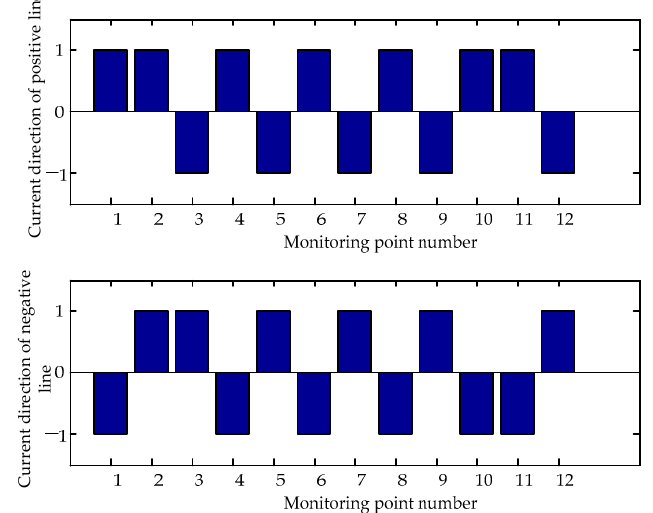
Figure 16. The current flow of monitoring points during pole ‐ to ‐ ground short ‐ circuit fault: ( a ) Positive line; ( b ) Negative line.